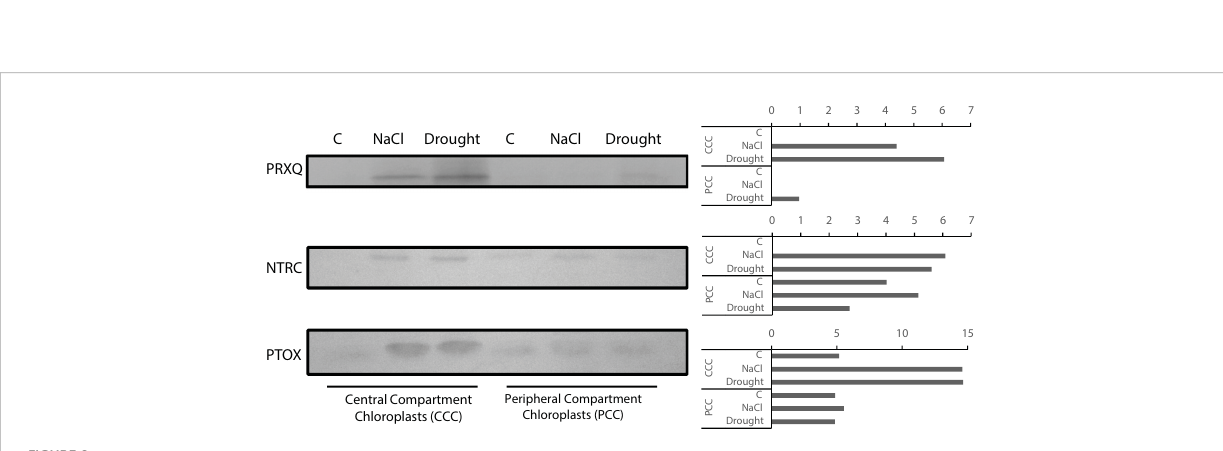
FIGURE 9 Levels of PRXQ, NTRC and PTOX proteins in CCC and PCC of Bienertia sinuspersici treated with 400 mM NaCl or water withholding for 10